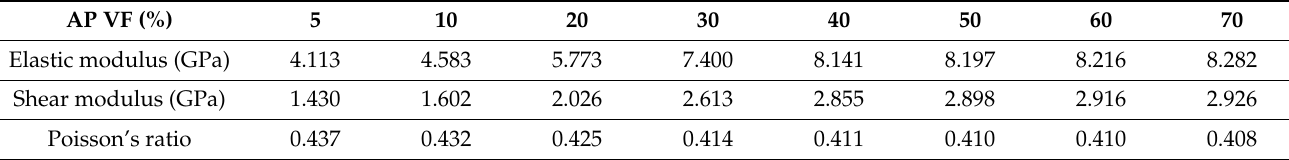
Table 3. FEM predictions of elastic modulus, shear modulus, and Poisson’s